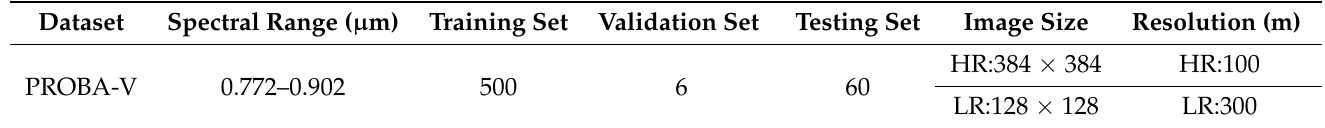
Table 1. The information of PROBA-V dataset used in this paper.